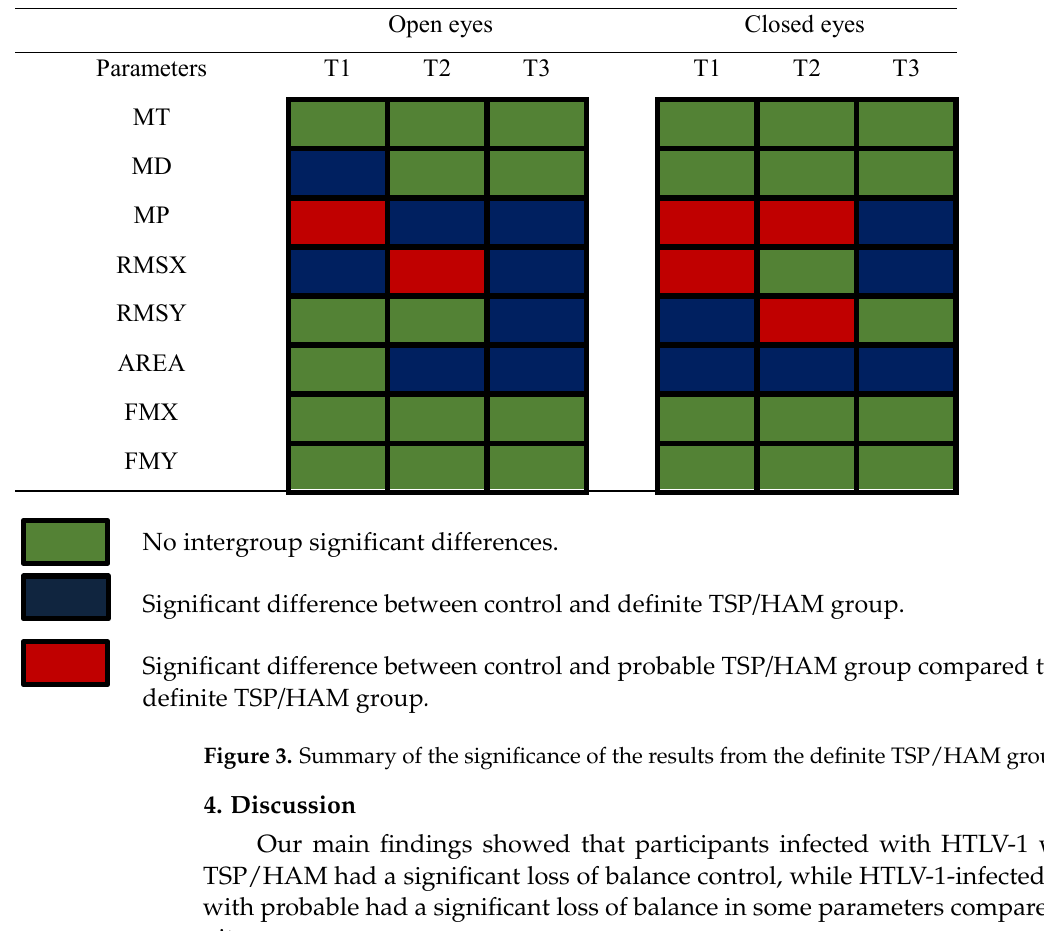
Figure 3. Summary of the significance of the results from the definite TSP/HAM group.